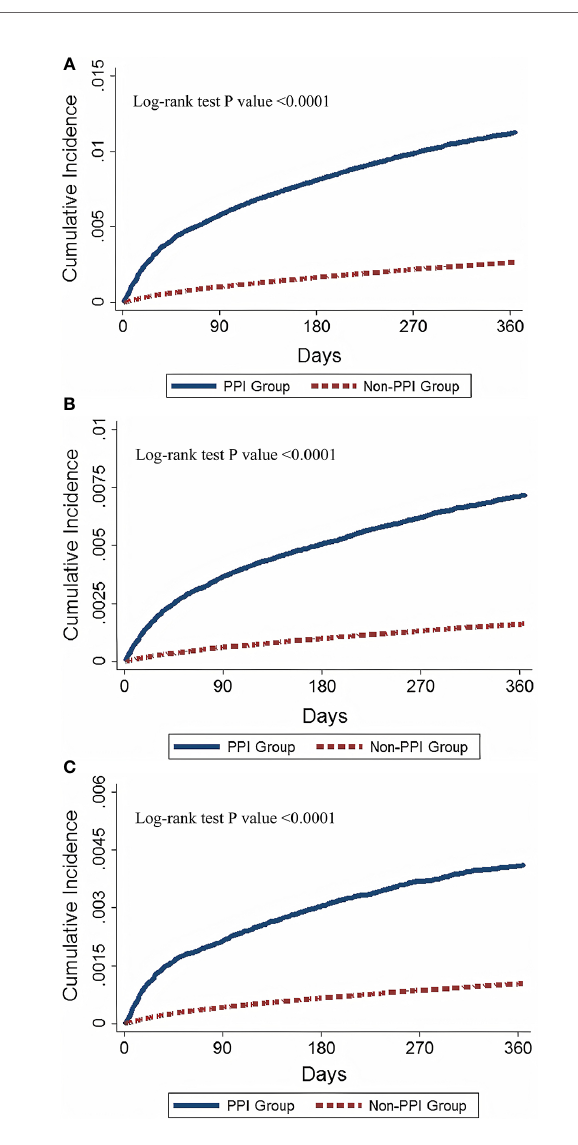
FIGURE 2 | Cumulative incidence of autoimmune diseases in PPI and non- PPI users. (A) Cumulative incidence of overall ADs for PPI and non-PPI users (B) Cumulative incidence of systemic ADs for PPI users and non-PPI users (C) Cumulative incidence of ADs in PPI users and non-PPI users. AD, autoimmune diseases. PPI, proton pump inhibitor.